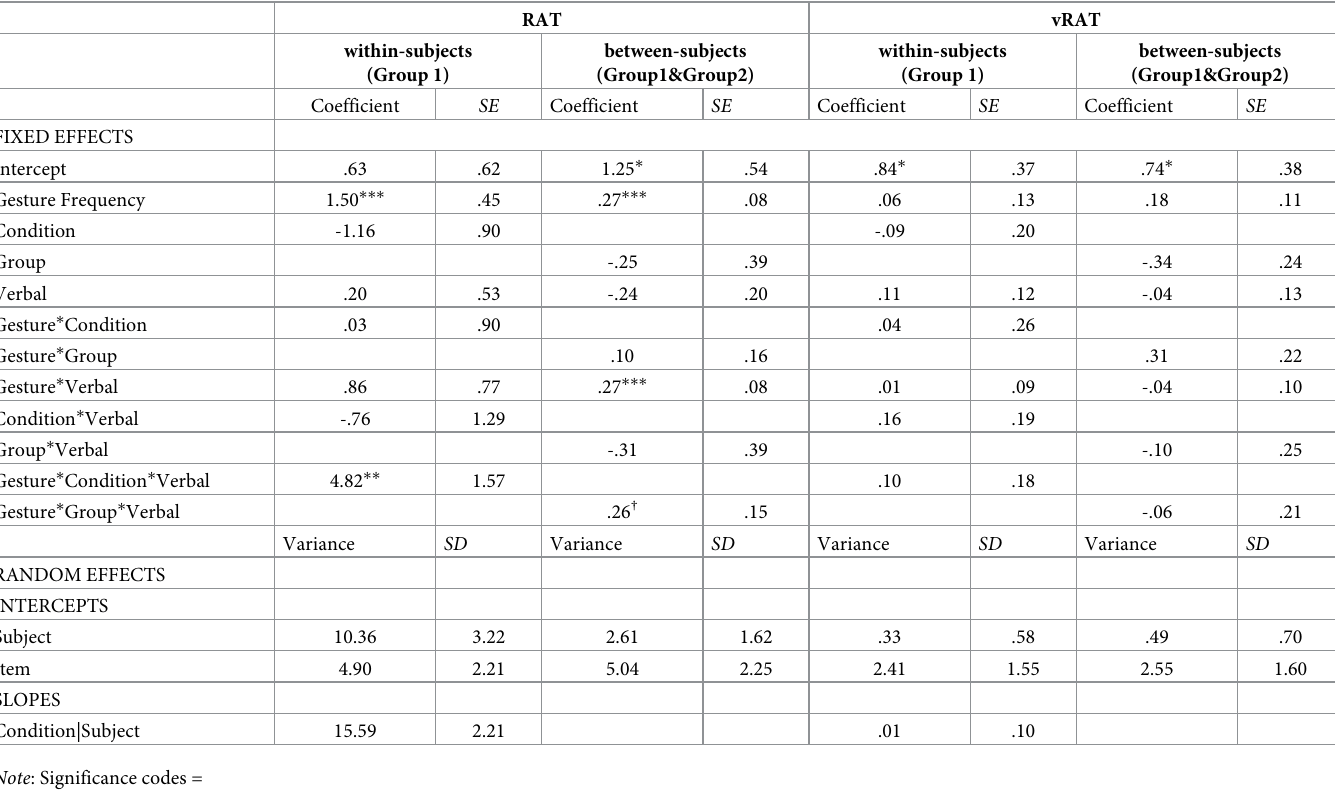
Table 7. Model summary for verbal cognitive